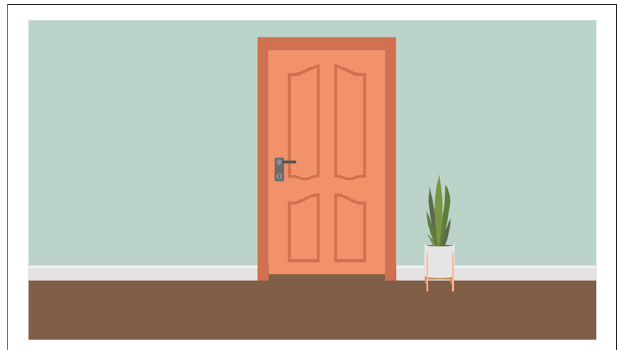
FIGURE 4 | Illustration used in VWT role-play interview showing the exterior of Rose ’ s fl